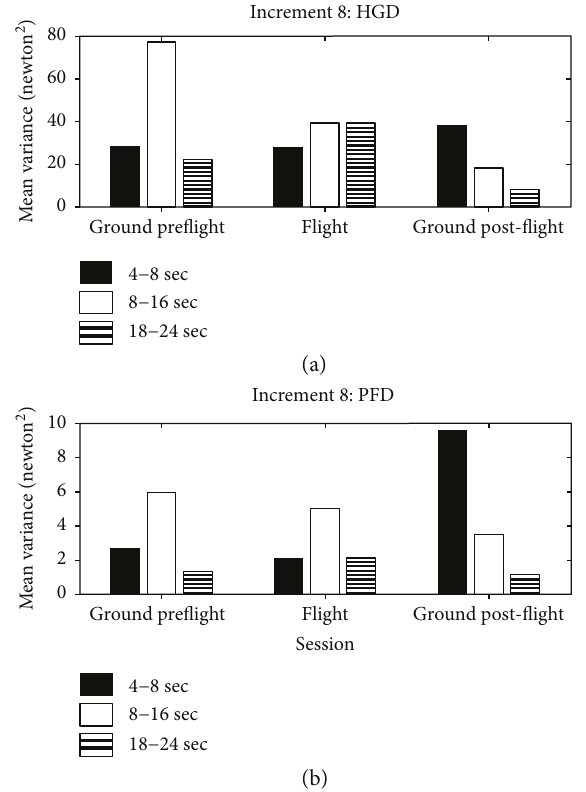
Figure 5: Force variance (FV). (a) FV parameter analysis for handgrip dynamometer (HGD) tests. (b) FV parameter analysis for pinch force dynamometer (PFD)